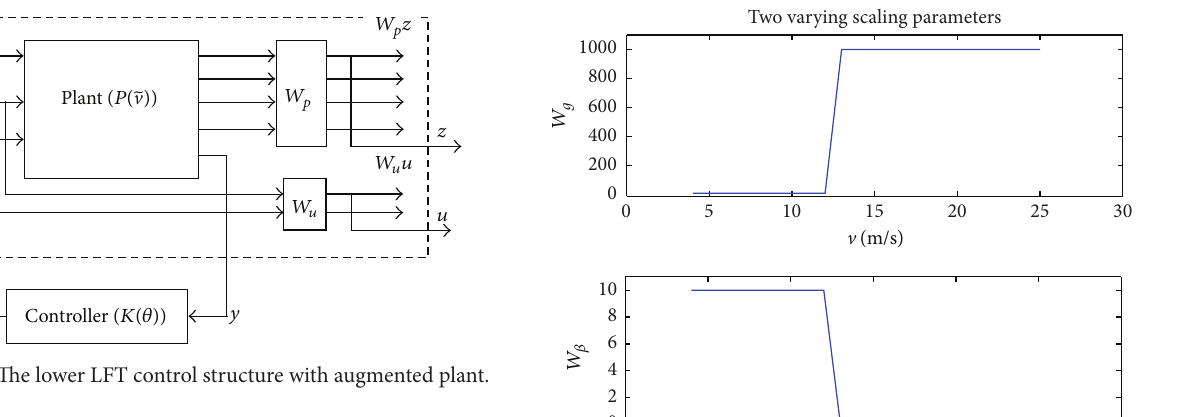
(𝜏 𝑠 + 1)/(𝜏 𝑠 + 1) in the Laplace notation. The weight 1 2 parameters are chosen as 𝜏 1 = 5 and 𝜏 2 = 0.1 . After applying